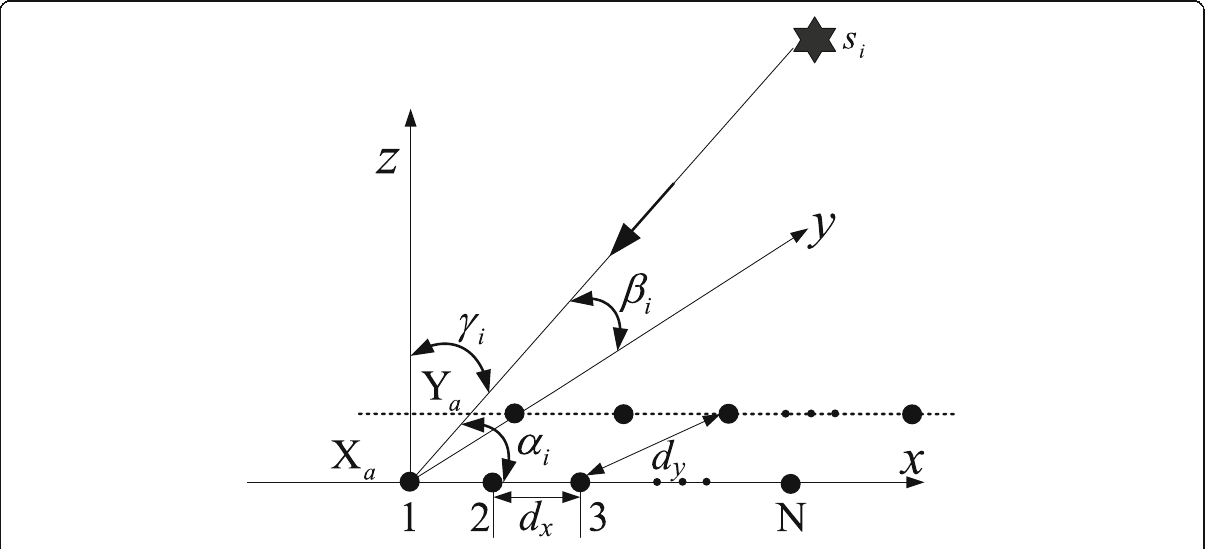
Fig. 1 Parallel array configuration for 2-D DOA